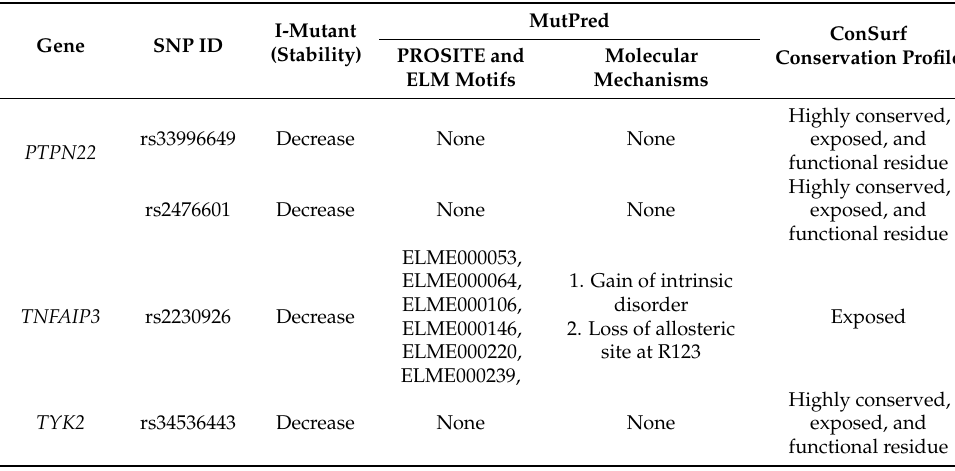
Table 5. Results predicted by I-Mutant, MutPred, and ConSurf for the important